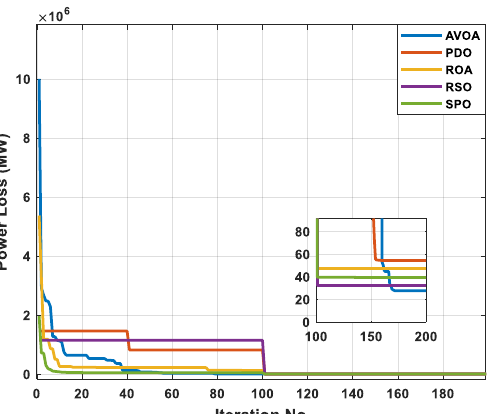
Figure 16. The AVOA convergence characteristics with the other compared methods for case 7.